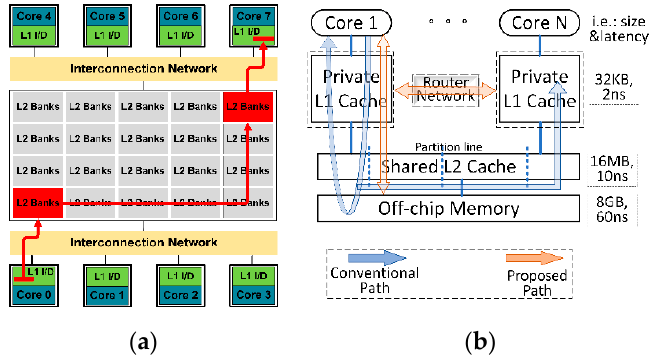
Figure 1. Processing cache paths of sharing data on conventional and proposed methods: ( a ) Classic CMP architecture; ( b ) Efficiency comparison between conventional path and proposed path.